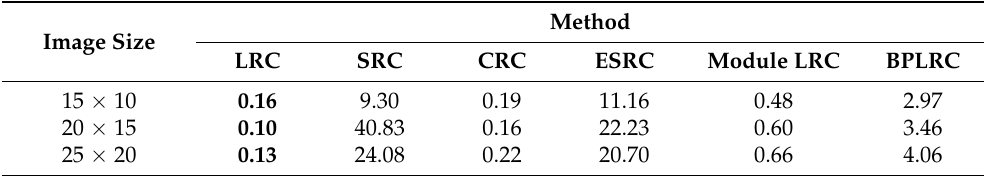
Table 9. Computational time (seconds) for different methods to identify 160 images.